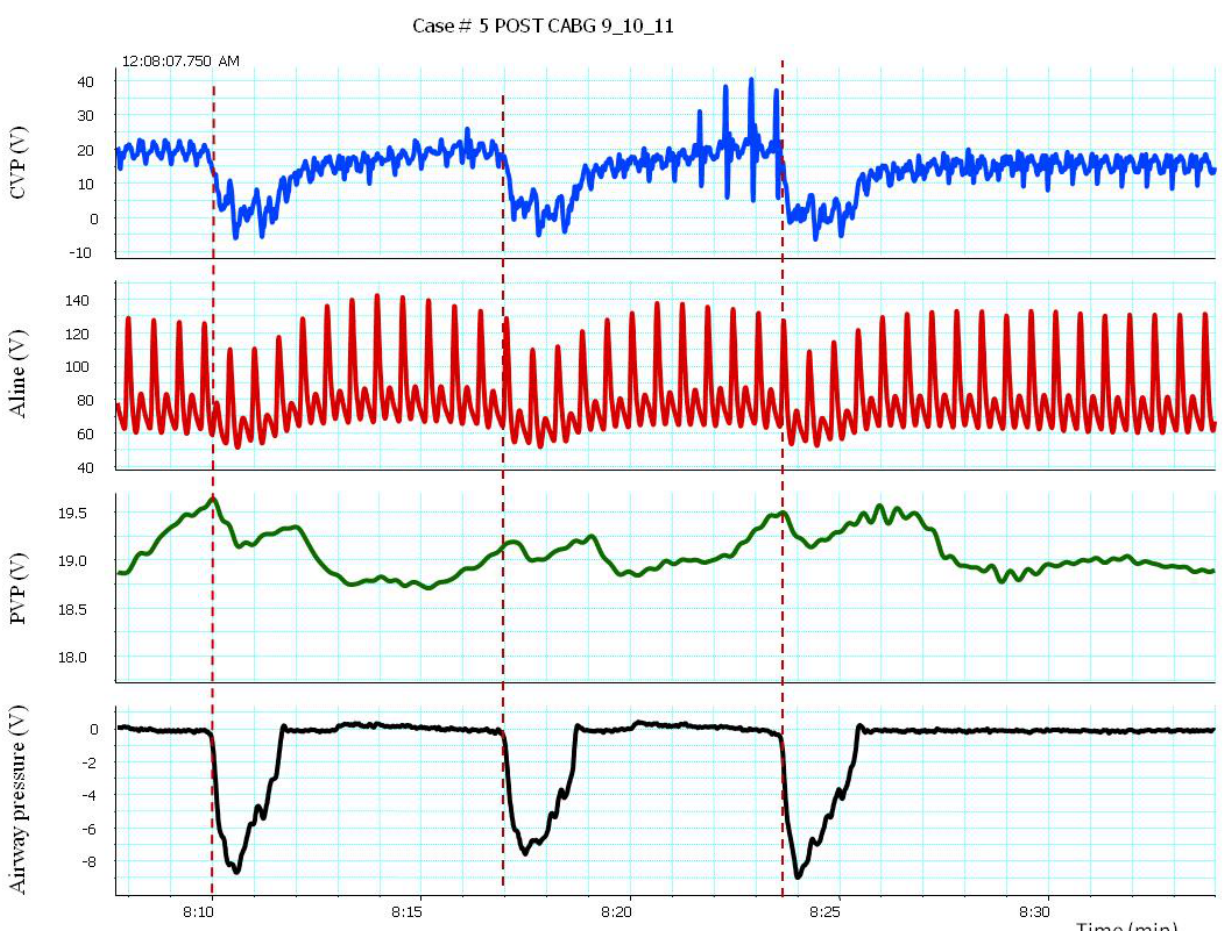
Figure 1. Impact of incentive spirometry, which induces a rapid deep breath, on arterial pressure, CVP and peripheral venous pressure (PVP). Notice that pulsus paradoxus occurs with inspiration.